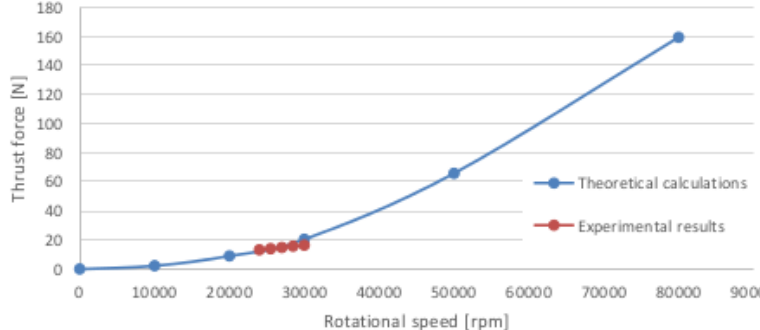
Figure 12: Theoretical and experimental axial